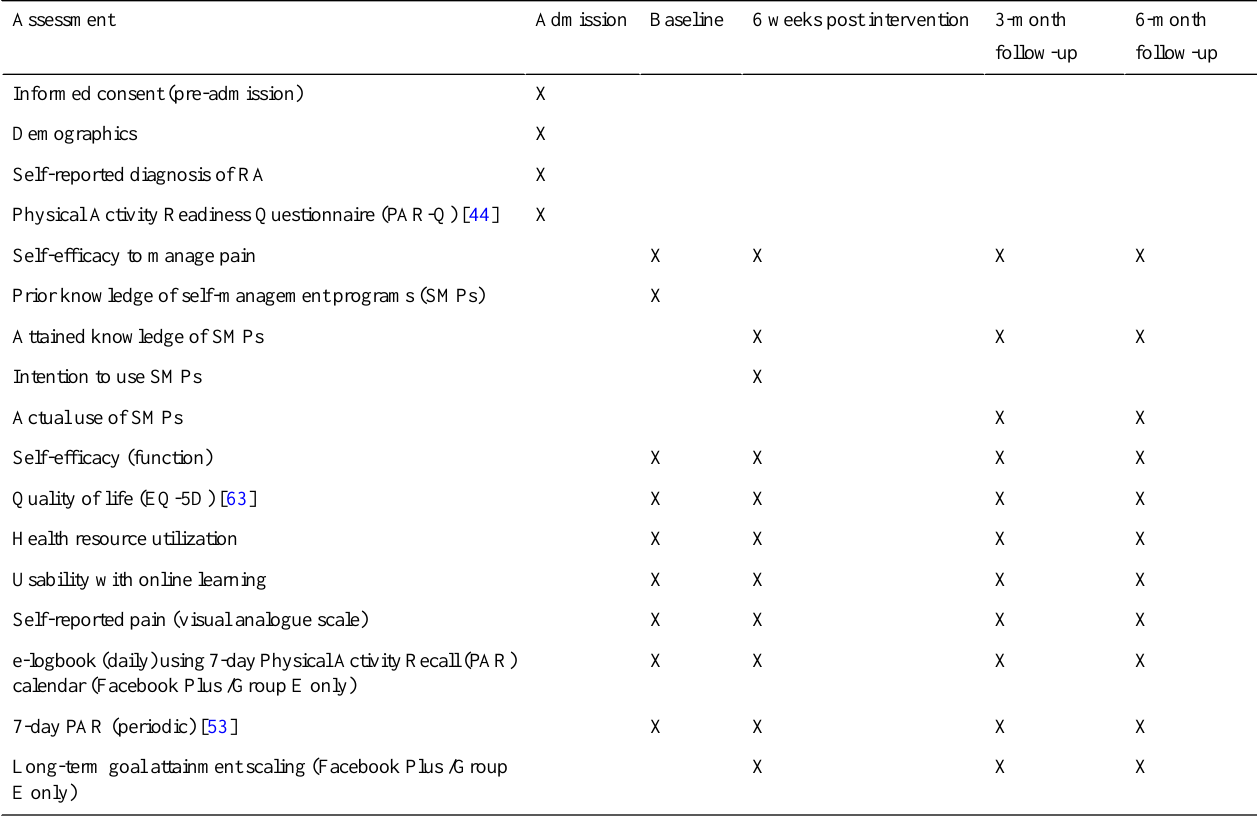
Table 2. Assessment schedule and additional outcome measures.